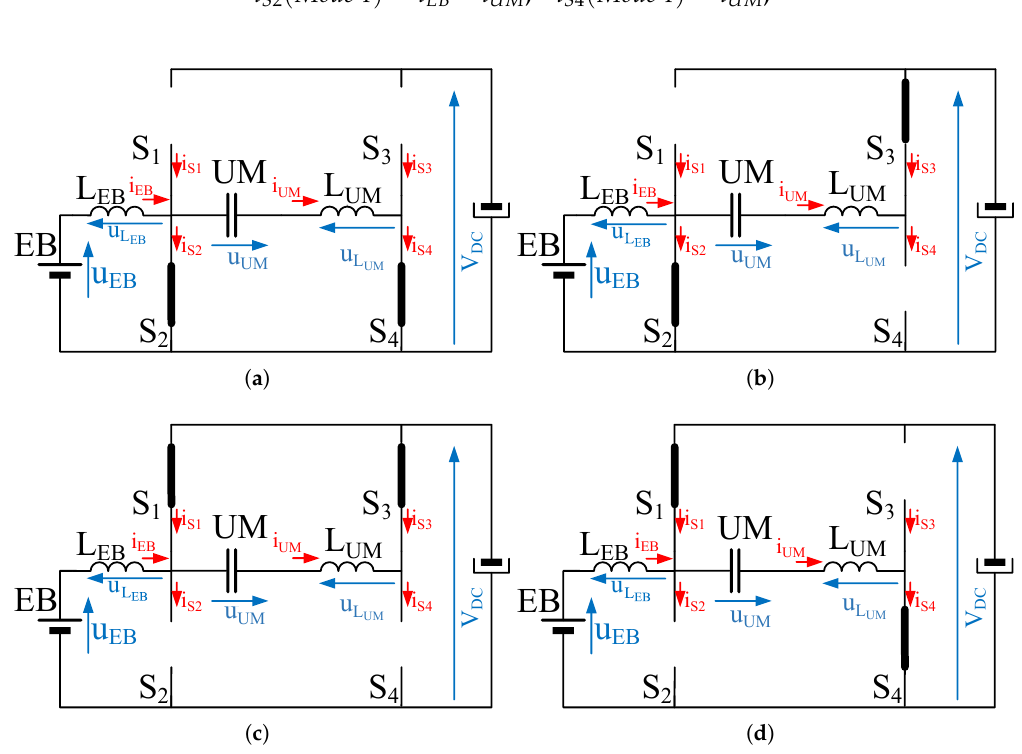
Figure 6. Switching modes in the SPC scheme: ( a ) Mode I; ( b ) Mode II; ( c ) Mode III; and ( d ) Mode